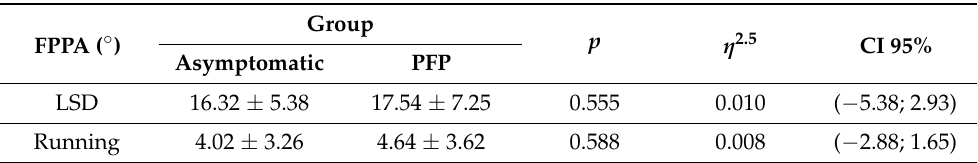
Table 3. Means and standard deviations (SDs) of the frontal plane knee projection angle (FPPA) during lateral step down (LSD) and running. Comparison between